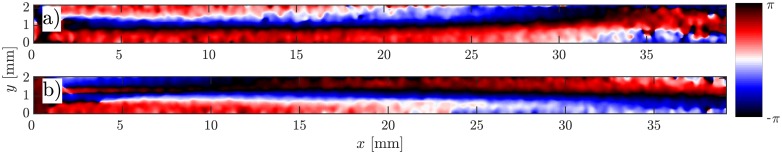
a) A half-parabolic shaped wave front observed at Vf = 10 mm/min. b) Two stripe-like waves initiating at top and bottom boundaries for flow speed of Vf = 15 mm/min.